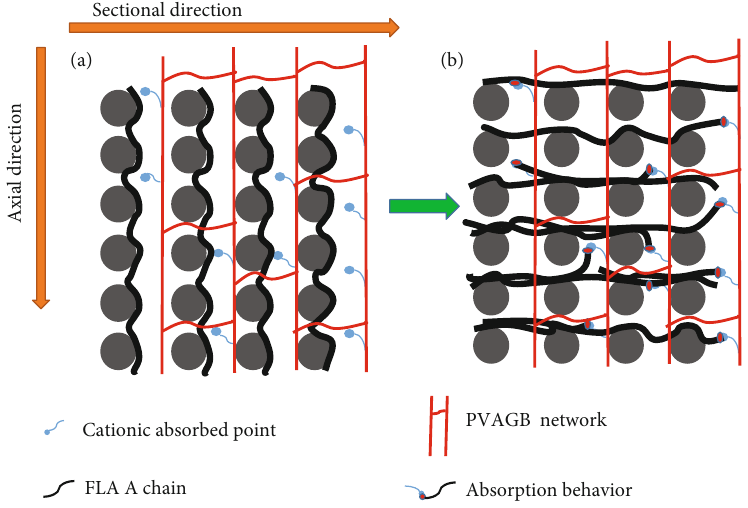
Figure 12: Formation of excellent fl uid loss control